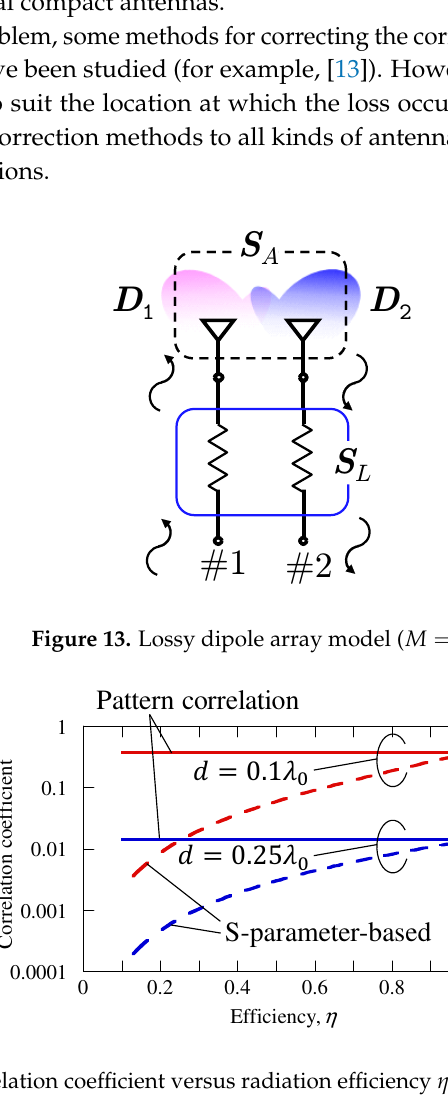
Figure 14. Correlation coefficient versus radiation efficiency η : dipole array ( M =